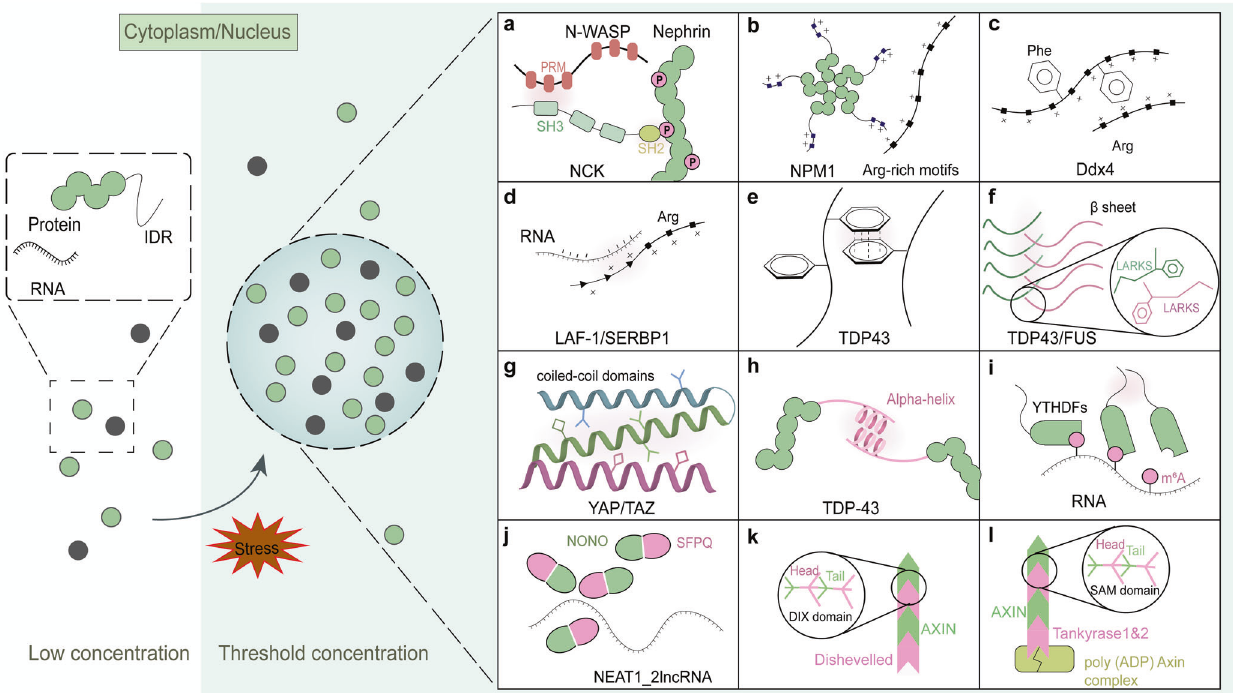
Fig. 1 Summary of various types of interactions that promote the occurrence and maintenance of LLPS. a Nephrin contains three phosphotyrosines (pTyrs) motifs, which bind the SH2 domain of Nck, and Nck possesses three SH3 domains that can bind the ~six proline-rich motifs (PRMs) of N-WASP. b The unphosphorylated form of the Npm1 monomer oligomerizes into pentamers through its N-terminus (Npm-N) and binds to proteins with Arg-rich linear motifs. c In Ddx4, Phe and Arg motifs in the intrinsically disordered regions (IDRs) drive LLPS. d In LAF-1 and SERBP1 proteins, the positively charged Arg/Gly-rich (RGG/RG) domain binds to negatively charged RNA and effectively promote LLPS. e In TDP43, the pi-pi interactions in IDRs facilitates LLPS. f Low-complexity amyloid-like reversible kinked segments (LARKS) in TDP43, and FUS proteins would give rise to phase separation via mediating reversible amyloid-like interactions. g Hydrophobic interactions existing in coiled-coil domains are essential for phase separation. h Local α -helix in the C-terminus of the TDP-43 protein enables TDP-43 self- connections and facilitates LLPS. i LLPS of YTHDF1 can be enhanced by the mRNAs with multiple m6A residues. j NEAT1_2 lncRNA subdomains selectively bind NONO/SFPQ proteins and dynamically oligomerize. k In the Wnt signaling cascade, Disheveled contacts the DIX domain of the AXIN protein in a head-to-tail manner and transduce Wnt signals into the nucleus. l SAM domains of tankyrase protein form dynamic puncta via head-to-tail polymerization with AXIN, promoting Wnt